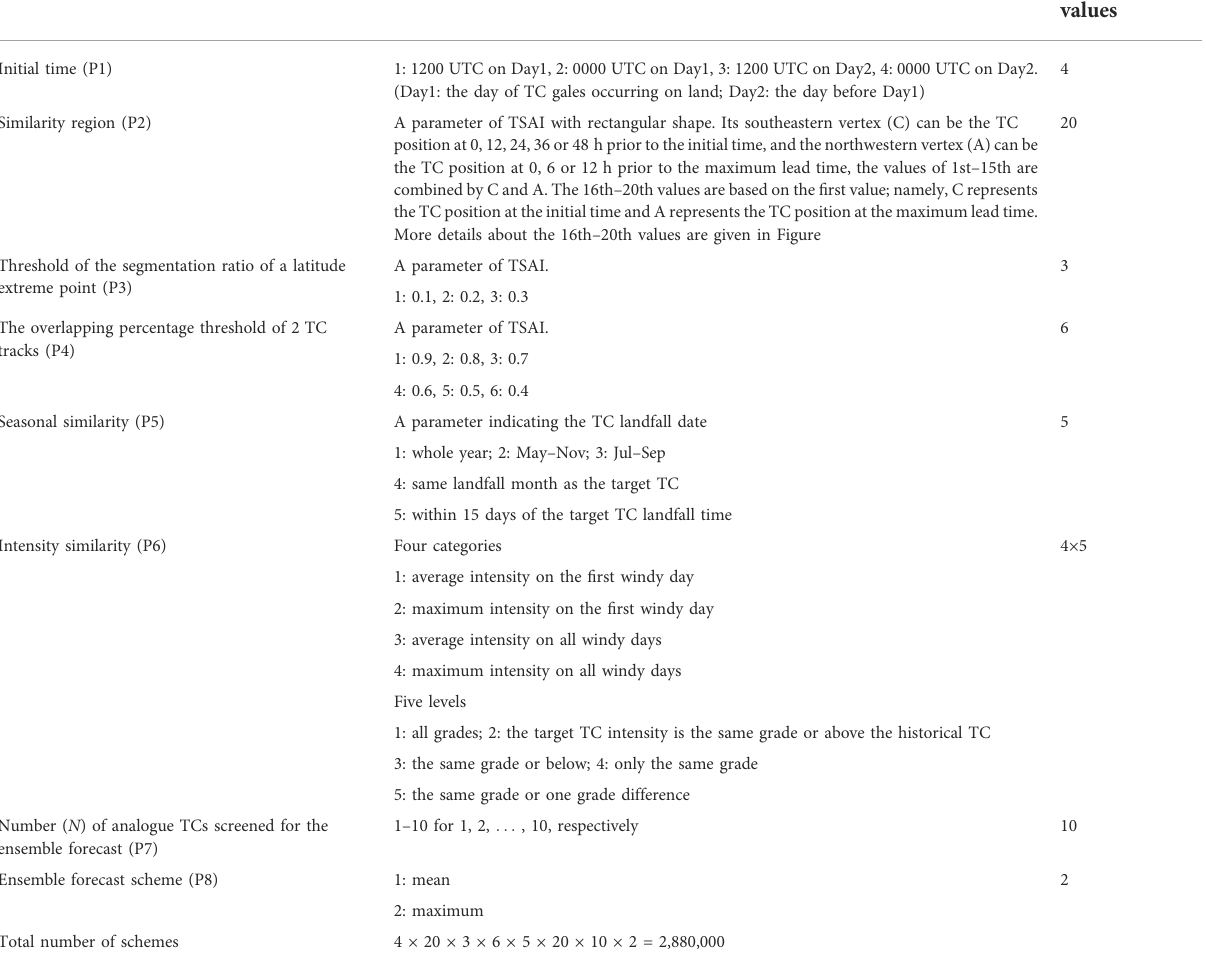
TABLE 1 Parameters of the DSAEF_LTG